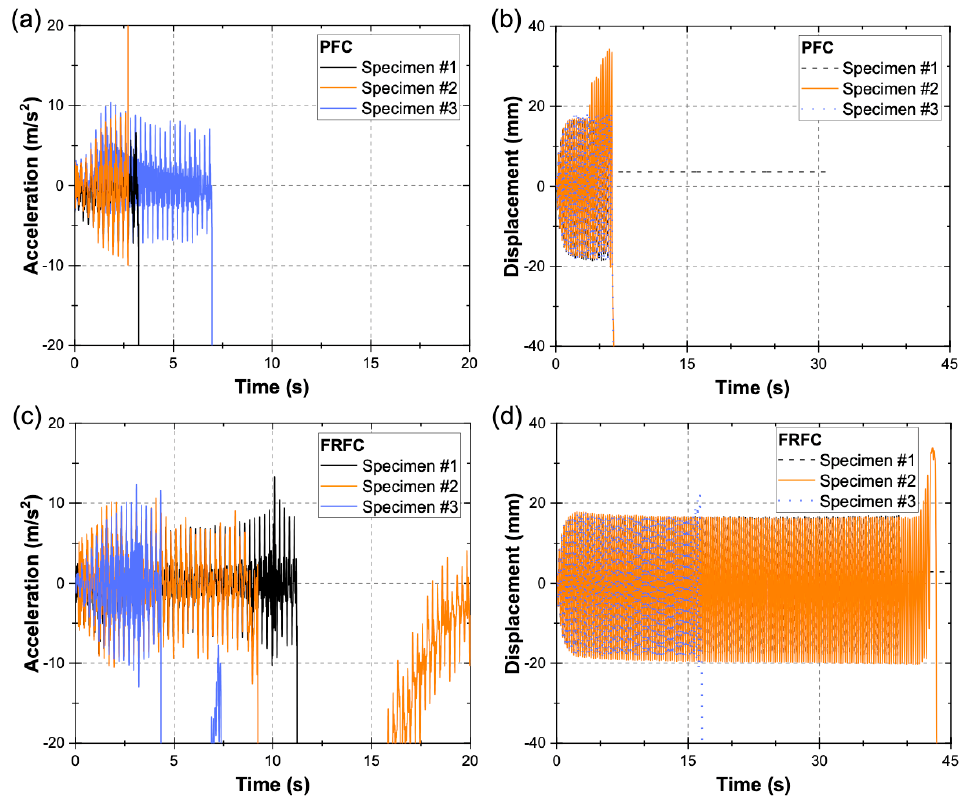
Figure 8. Time-history plots of ( a ) acceleration and ( b ) displacement for PFC specimens. Time-history plots of ( c ) acceleration and ( d ) displacement for FRFC specimens.